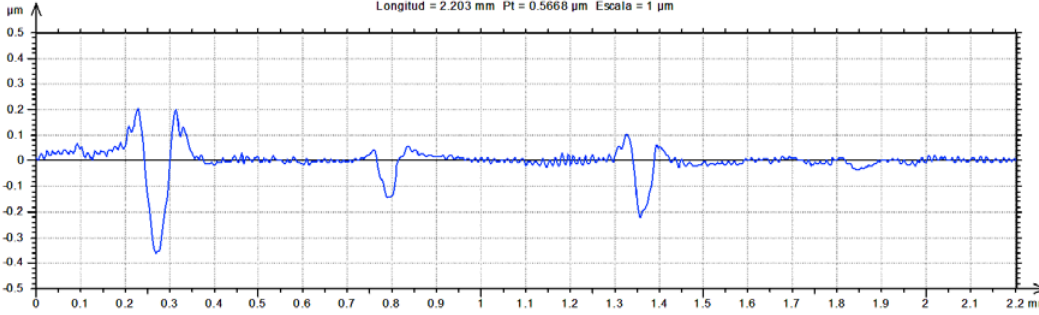
Figure 7. Cross section profiles on AISI 316L disks after the tribological tests with the four lubricants.